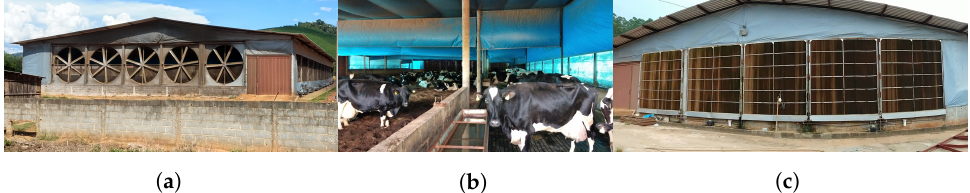
Figure 1. Tunnel-ventilated compost-bedded pack barn. ( a )—Fan exhaust. ( b )—Inside. ( c )—Evaporative cooling